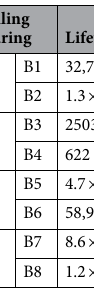
Table 6. Lifetime of bearings in maize harvester gearbox in LDD.